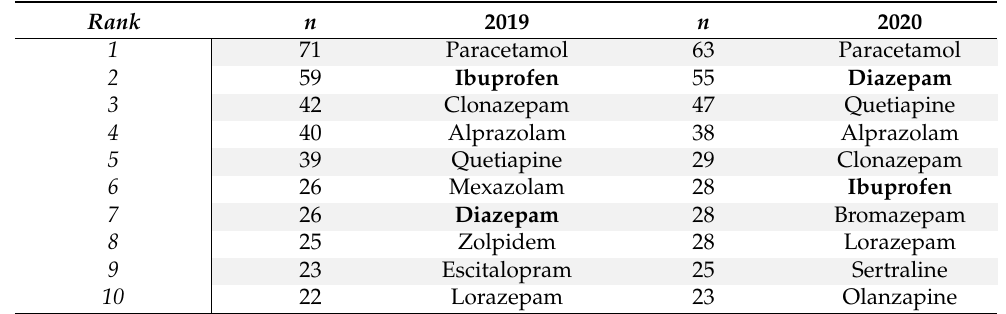
Table 1. Drugs involved in intoxications grouped in descending order relative to the years 2019 and 2020, according to the number of cases identified.